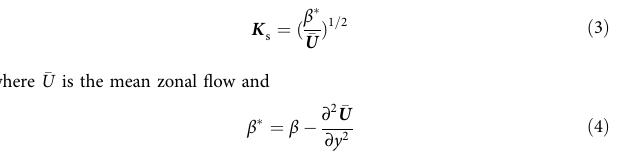
NCAR reanalysis 54 700-hPa height anomalies onto the leading EOF mode, and are normalised by the standard deviation of the monthly index (1979 – 2000 base period). For better representing SAM impact on Antarctic sea-ice, an alternative zonal wind index is introduced. This index is de fi ned as the zonal and meridional averaged zonal wind at 850 hPa. The meridional average is from 60°S to 65°S. We choose this latitudinal band because the annual and zonal average of the Antarctic sea-ice edge, de fi ned as the equatorward position of 15% contour of SIC, is near 65° S. We name this index as U 60 – 65S . The correlation r between monthly U 60 – 65S and the CPC SAM index over 1979 – 2015 ranges from 0.89 – 0.91 for different seasons (for Nov – Dec r = 0.91, p <0.01). Rossby wave source, wave activity fl ux and wave numbers . An enhanced tropical convection anomaly induces vertical motion anomaly and the associated lower-level convergence and upper-level divergence anomaly, which produce an anomalous vorticity source in the tropics. The upper level component of this vorticity source, denoted the Rossby wave source (RWS) 55 and can be de fi ned as (cid:1) ζ (cid:2) (cid:1) ζ D ′ ð RWS ¼ (cid:2) v χ (cid:3) ∇ ζ (cid:2) ζ D (cid:4) (cid:2) v ′ χ (cid:3) ∇ 1 Þ where ζ is the 2D absolute vorticity, v χ is the divergent component of the horizontal wind vector and D is the horizontal wind divergence, and the overbar and prime represent the climatological mean and perturbation, respectively. The RWS are well (cid:1) ζ approximated by their linearised components S1 ( (cid:2) v ′ χ (cid:3) ∇ ), the advection of mean (cid:1) ζ D ′ absolute vorticity by anomalous divergent fl ow, and S2 ( (cid:2) ), the vortex stretching term, or the generation of vorticity by anomalous divergence 56 . Here we only show S1, as this component is more effective at exciting extratropical tele- connections from the tropical heating 55 . Rossby wave activity fl ux 57 is used to investigate the Rossby wave propagation from the tropics. This diagnostic tool illustrates the evolution and propagation of stationary Rossby wave disturbances on a zonally varying basic fl ow. For slowly varying basic fl ows, the wave activity fl ux W is parallel to the local group velocity. Here we focus on horizontal component of W on 200 hPa: